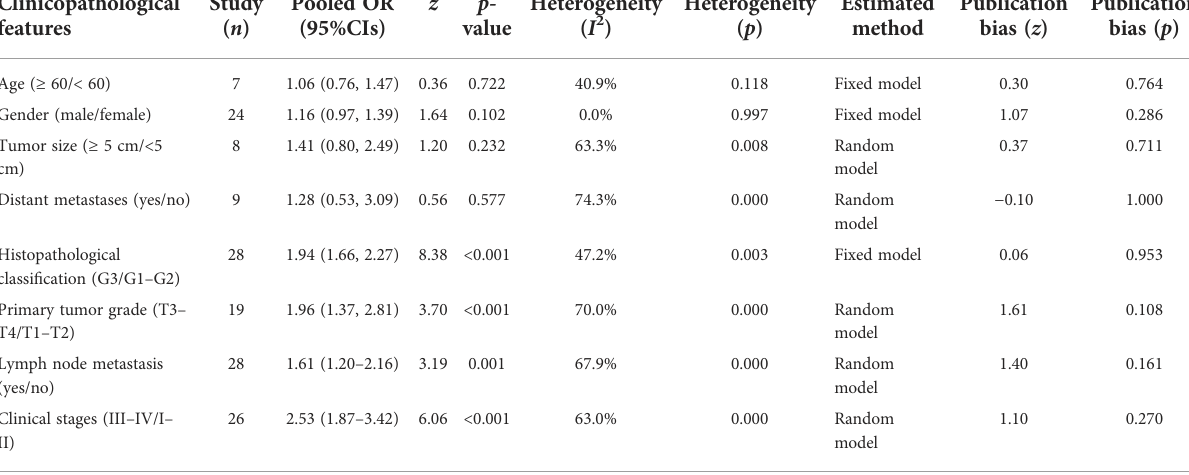
TABLE 2 Main results for the meta-analysis between PLK-1 and clinicopathological features in multiple cancers. Clinicopathological